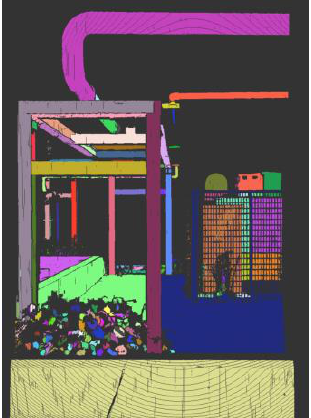
Figure 2. Example of region-growing clustering for a facility with complex structures.